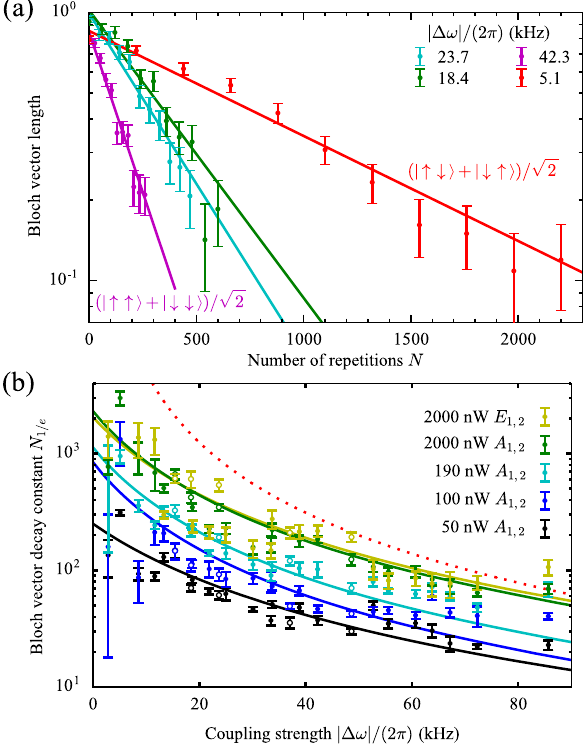
FIG. 4. Encoding of a quantum bit in decoherence-protected subspaces. (a) Encoding in nuclear spin 2 or 3 (cyan and green) shows similar decay with increasing N . Encoding in a decoherence-protected (decoherence-enhanced) subspace leads to strongly decreased (enhanced) dephasing shown in red (magenta). The initial fidelity in the two-spin case is slightly reduced because encoding and readout require more control operations on the nuclear spins. (b) Number of sequence repetitions that are possible before the nuclear qubit Bloch vector length drops to 1 =e of its initial value, for qubits encoded in single nuclear spins (empty circles) and in two-spin states (filled circles) of different effective coupling strengths Δ ω . The four depicted data sets are taken for increasing repump duration, caused by a reduced repump laser power. The solid curves are fits according to the model we present in the